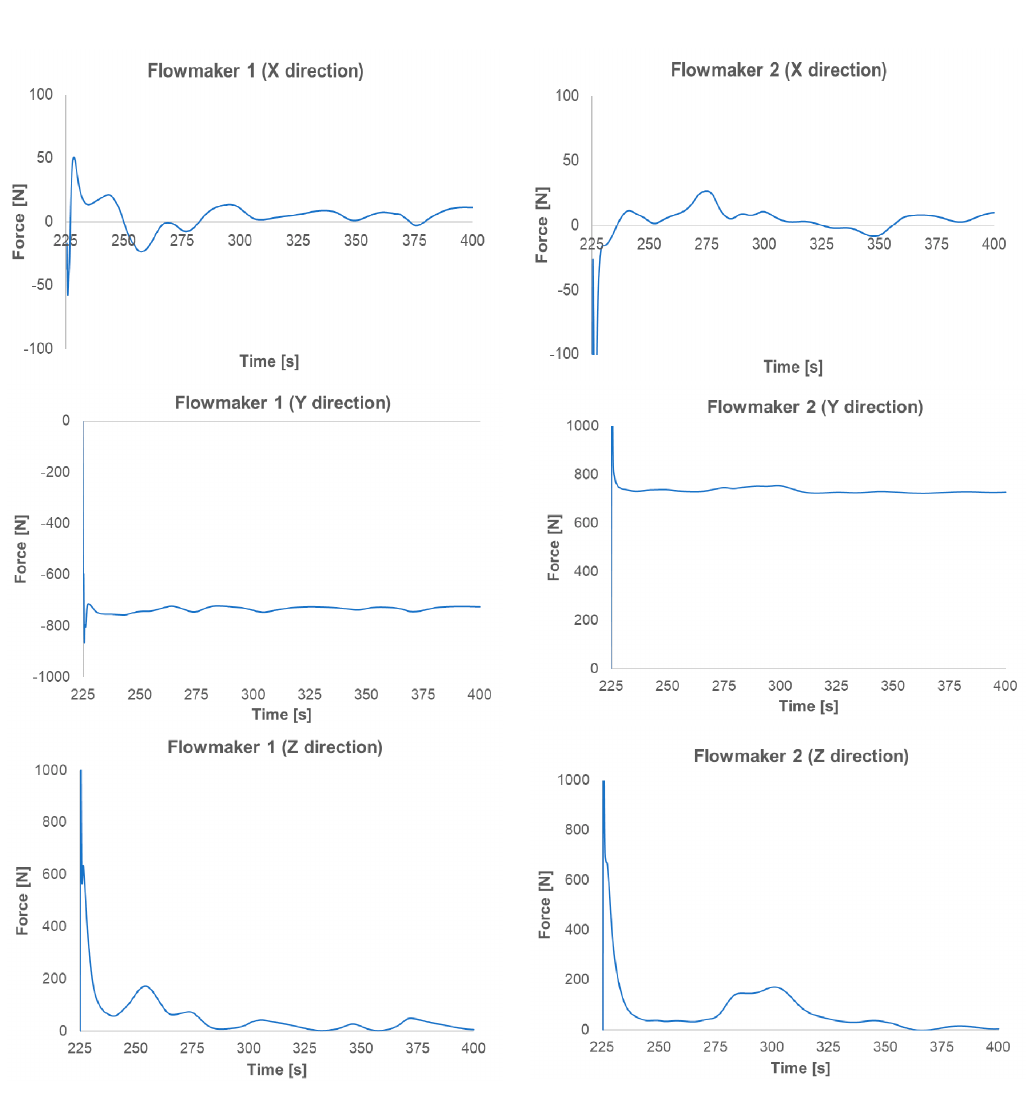
Figure 10. Normal force on the blades in axial (Z) and radial (X and Y) directions after stopping the flowmakers.